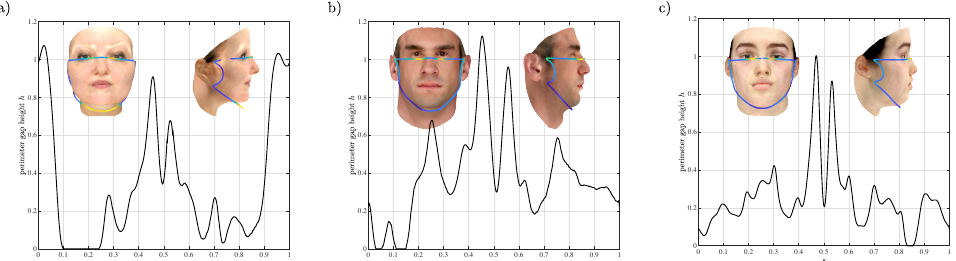
Figure 1. ( a ) Female ( b ) male, and ( c ) child faces considered in this